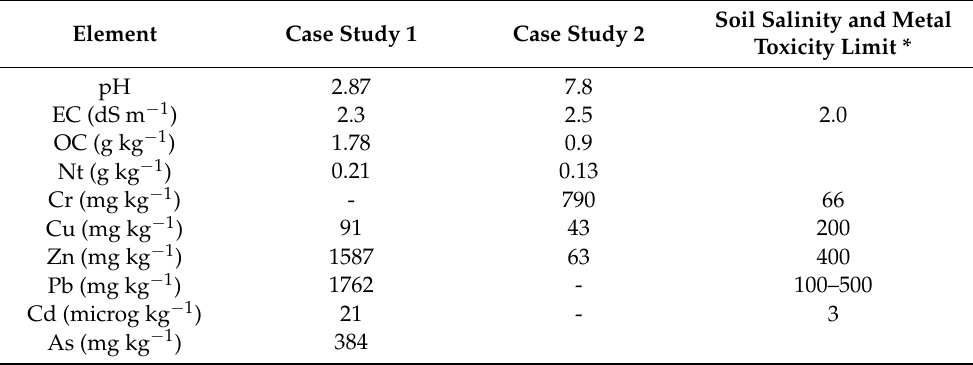
Table 2. Initial soil analysis of the case studies (EC: electrical conductivity; OC: organic carbon; Nt: total Nitrogen, organic and inorganic). Element Case Study 1 Case Study